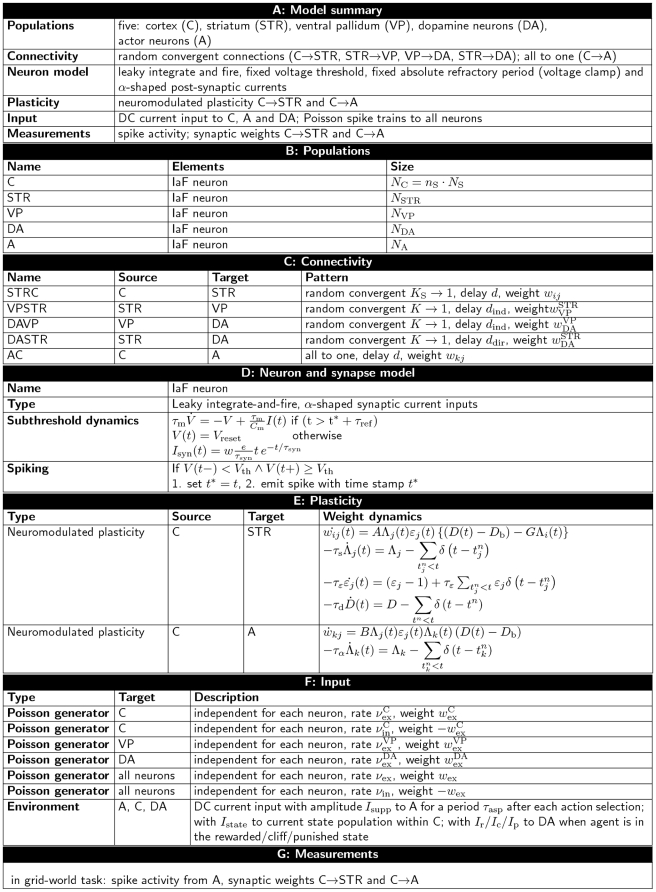
Model description after [107].